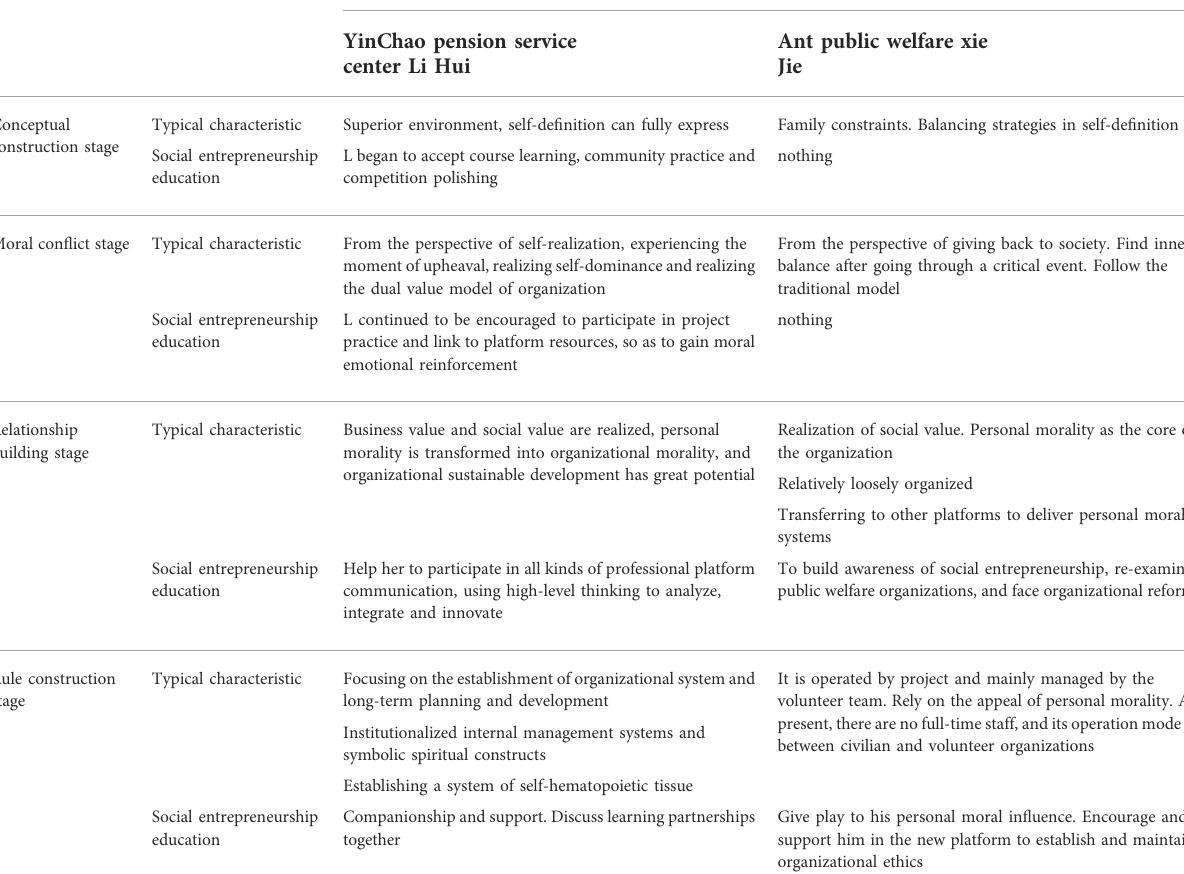
TABLE 8 Comparative analysis of the case